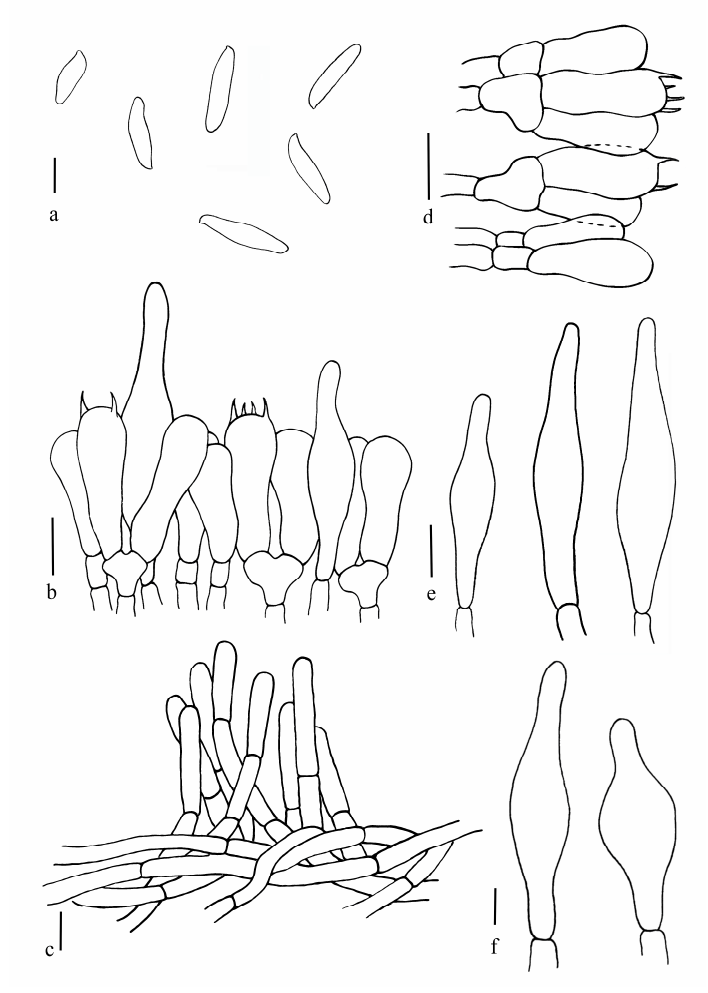
Figure 6. Butyriboletus pseudoroseoflavus . ( a ) Basidiospores; ( b ) Basidia and pleurocystidia; ( c ) Pileipellis; ( d ) Stipitipellis; ( e ) Pleurocystidia; ( f ) Cheilocystidia. Scale bars: ( b – e ) = 10 μm; ( a , f ) =5 μm.